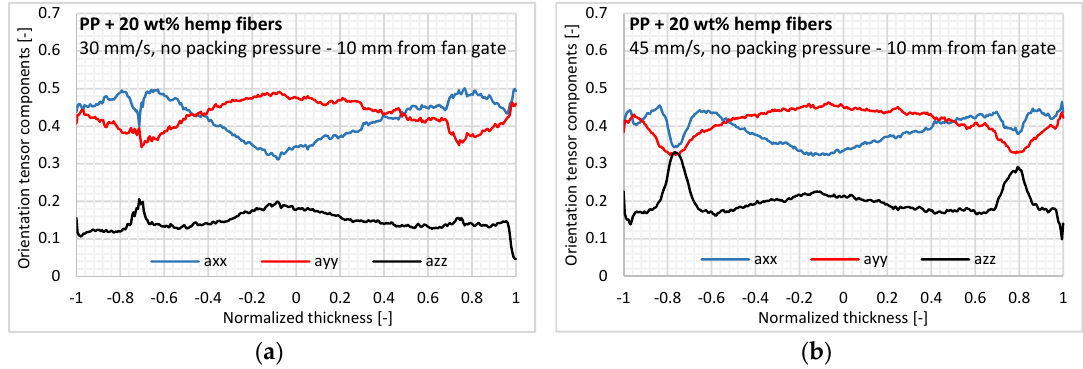
Figure 7. In-thickness fiber orientation for two injection ram speeds: ( a ) 30 and ( b ) 45 mm/s. A thicker core layer with transversely oriented fibers is also barely identified at a high flow rate without packing pressure. Indeed, a higher injection velocity reduces the thickness of the solidified layer during filling. The skin layer thickness is reduced by a consistent value of 50 µm (2.3% of the entire thickness) at each side of the sample at a high flow rate (Figure 8). Then, after filling the molten polymer, the flow channel is enlarged in the cavity, thus inducing a larger core layer with transverse orientation [16].